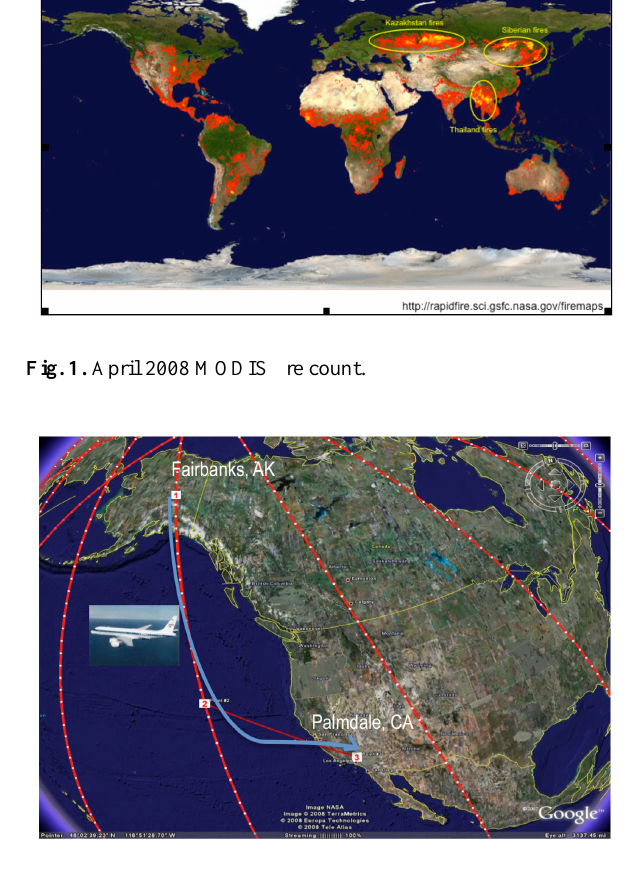
Fig. 2. Flight 11 (19 April 2008) Figure 2: Flight 11 (04/19/08) track